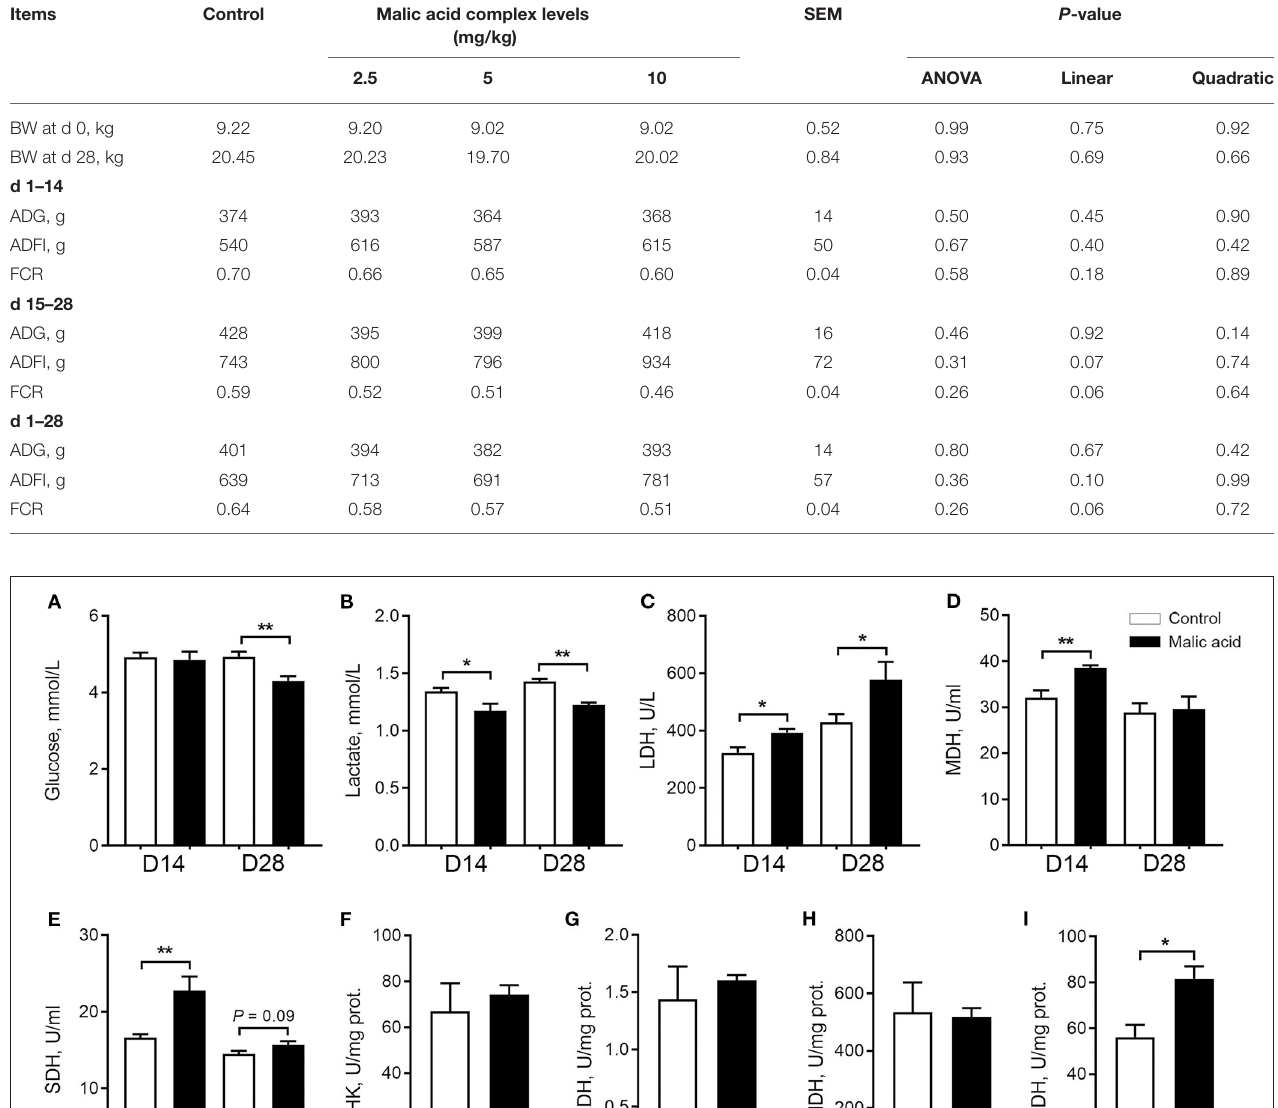
TABLE 1 | Effects of dietary malic acid supplementation on the growth performance of weaned piglets ( n = 6). Items